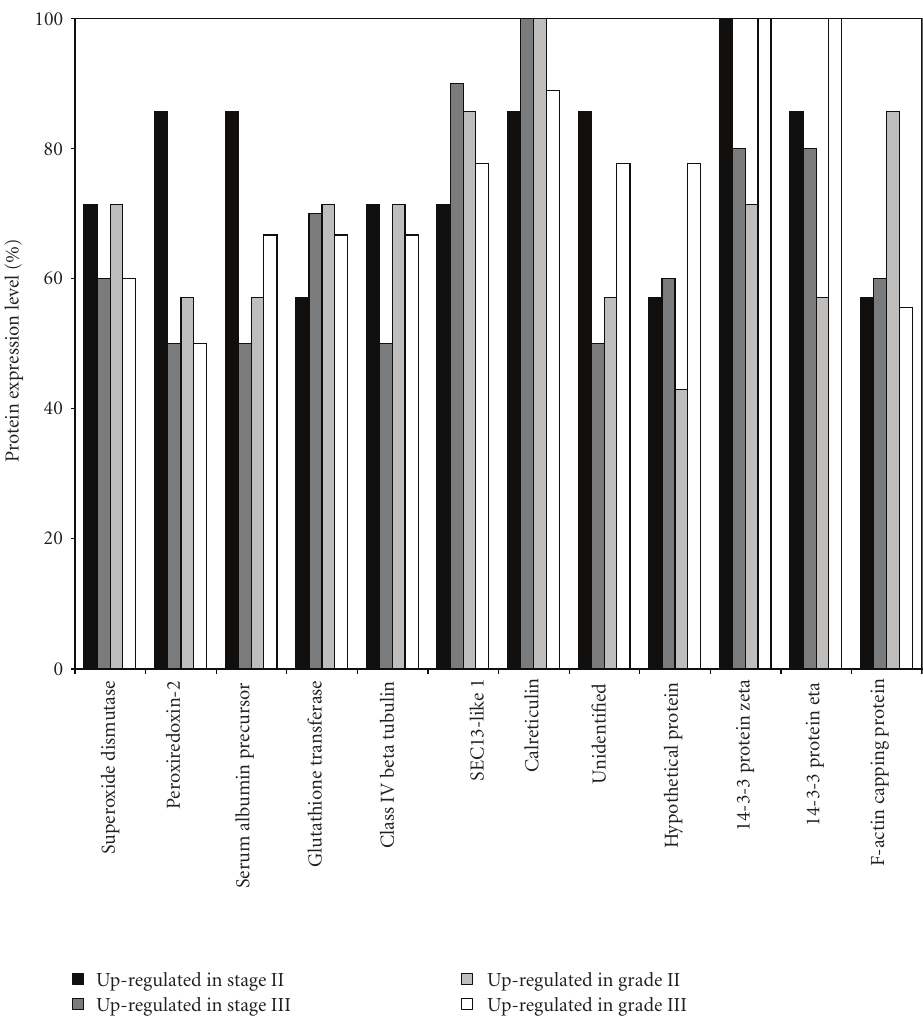
Figure 10: Comparison of up-regulated proteins in Stage II, Stage III, Grade II and Grade III